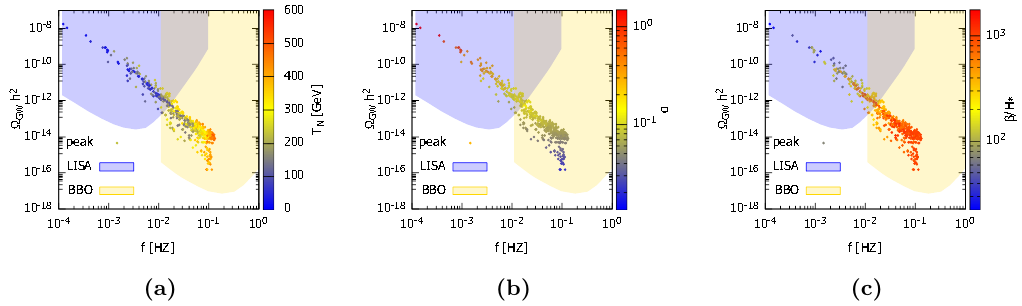
Figure 9. The peak of GW spectrum against frecuency. LISA and BBO sensitivities are also de- picted.